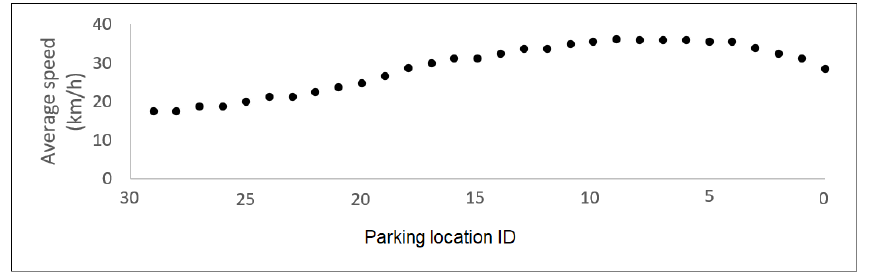
Figure 6. Average speed profile along the parking sections.